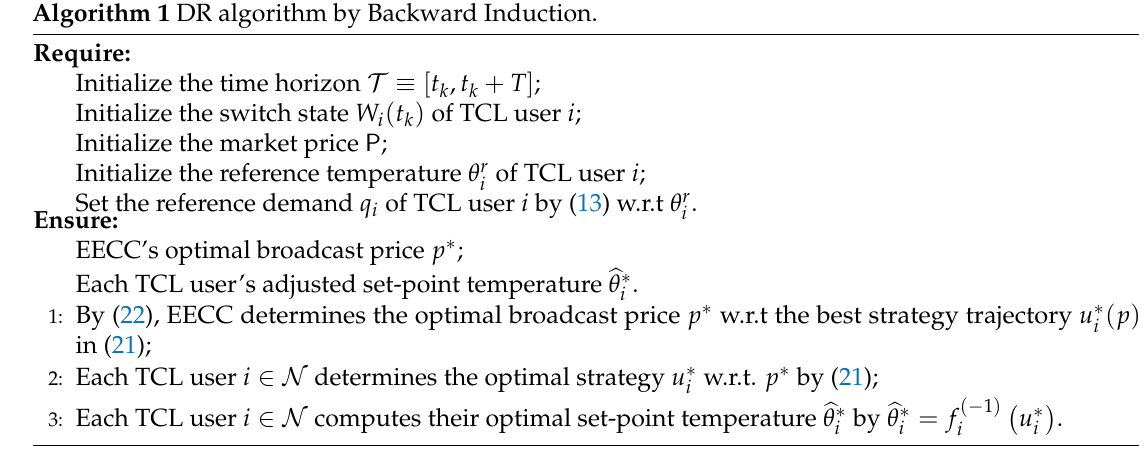
Algorithm 1 DR algorithm by Backward